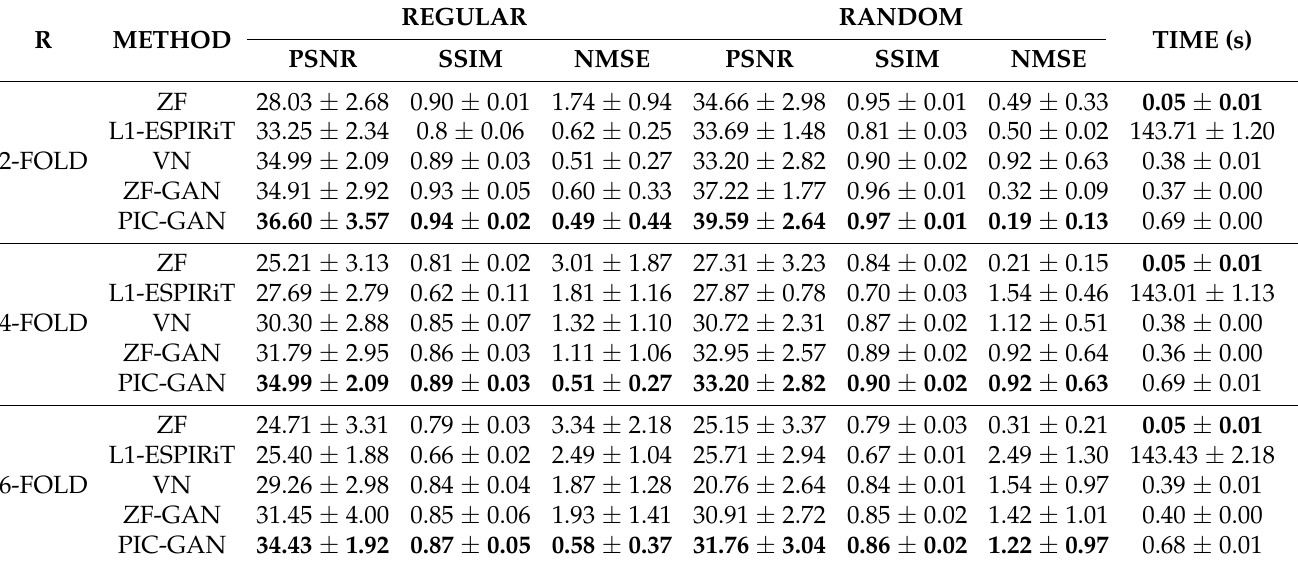
Table 1. Performance comparisons (Normalized Mean Square Error (NMSE) × 10 − 5 , Structural Similarity Index (SSIM), Peak Signal to Noise Ratio (PSNR) and Average Reconstruction Time(s)) on abdominal magnetic resonance imaging (MRI) data with different acceleration factors. The bold numbers highlight the best results. The PIC-GAN outperformed the competing algorithms with significantly higher PSNR, SSIM and lower NMSE values ( p <